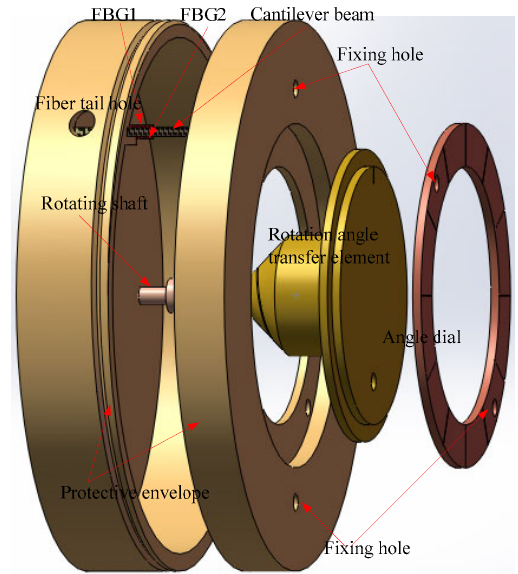
Fig. 1 Composition and structure of the proposed FBG rotation angle